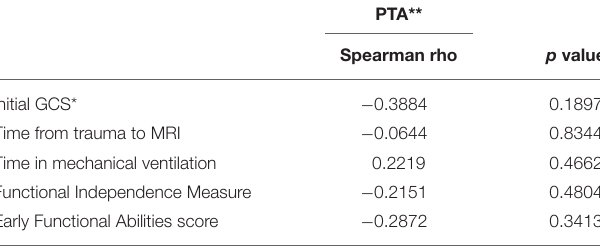
TABLE 3 | Correlation between clinical variables and outcome